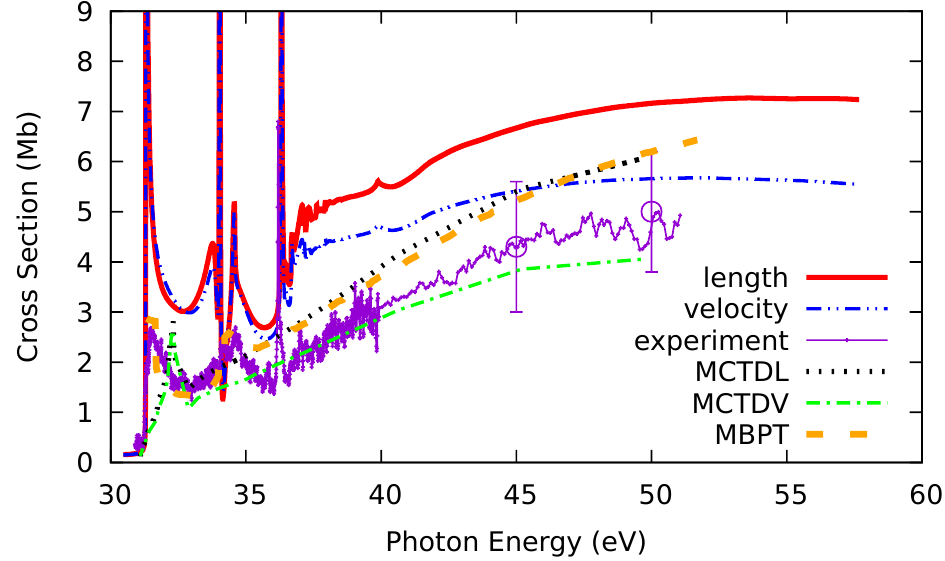
Figure 4. Photodetachment of Na − : Present R-matrix cross sections compared to earlier theoretical results: the Multiconfiguration Tamm-Damcoff results [21] in length (MCTDL) and velocity (MCTDV) forms, as well as many-body perturbation theory (MBPT) results